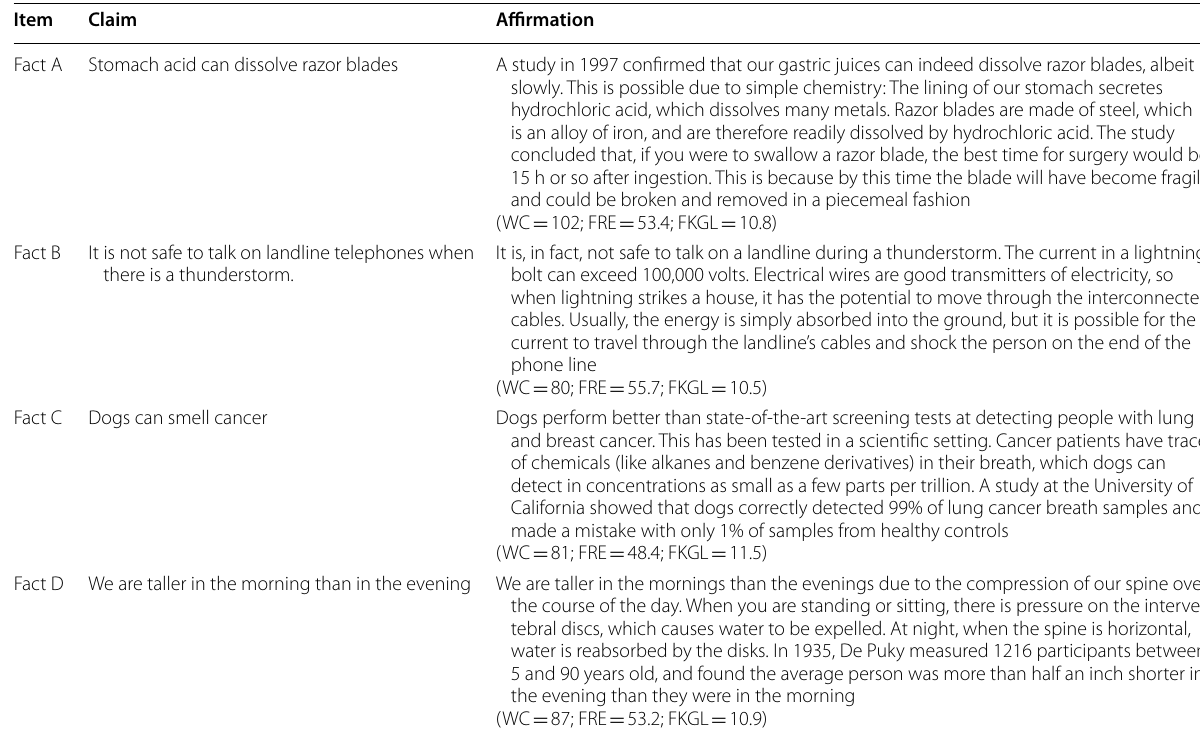
WC, Word Count; FRE, Flesch Reading Ease; FKGL, Flesch–Kincaid Grade Level